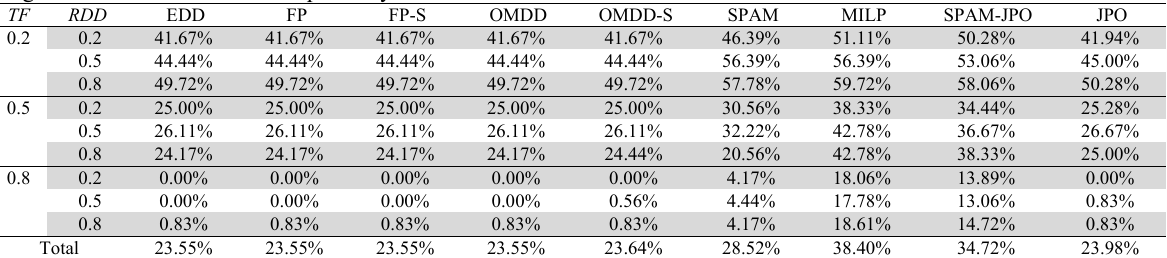
Large-sized test instances: % of optimality for TF and RDD